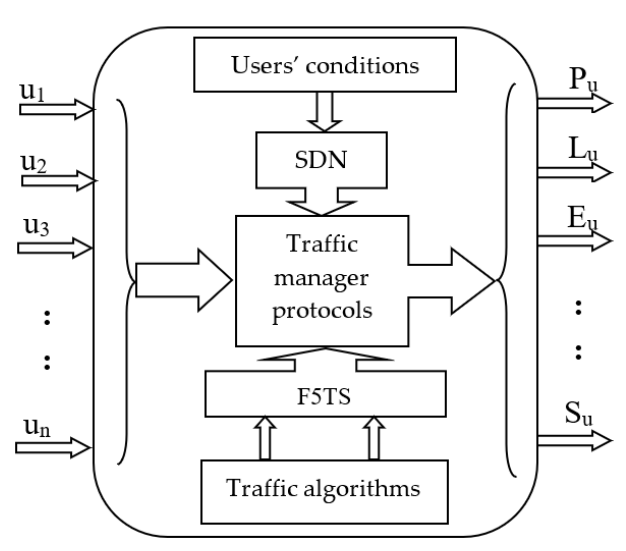
Figure 3. Managing issues of transportation services and infrastructure with F5TS.